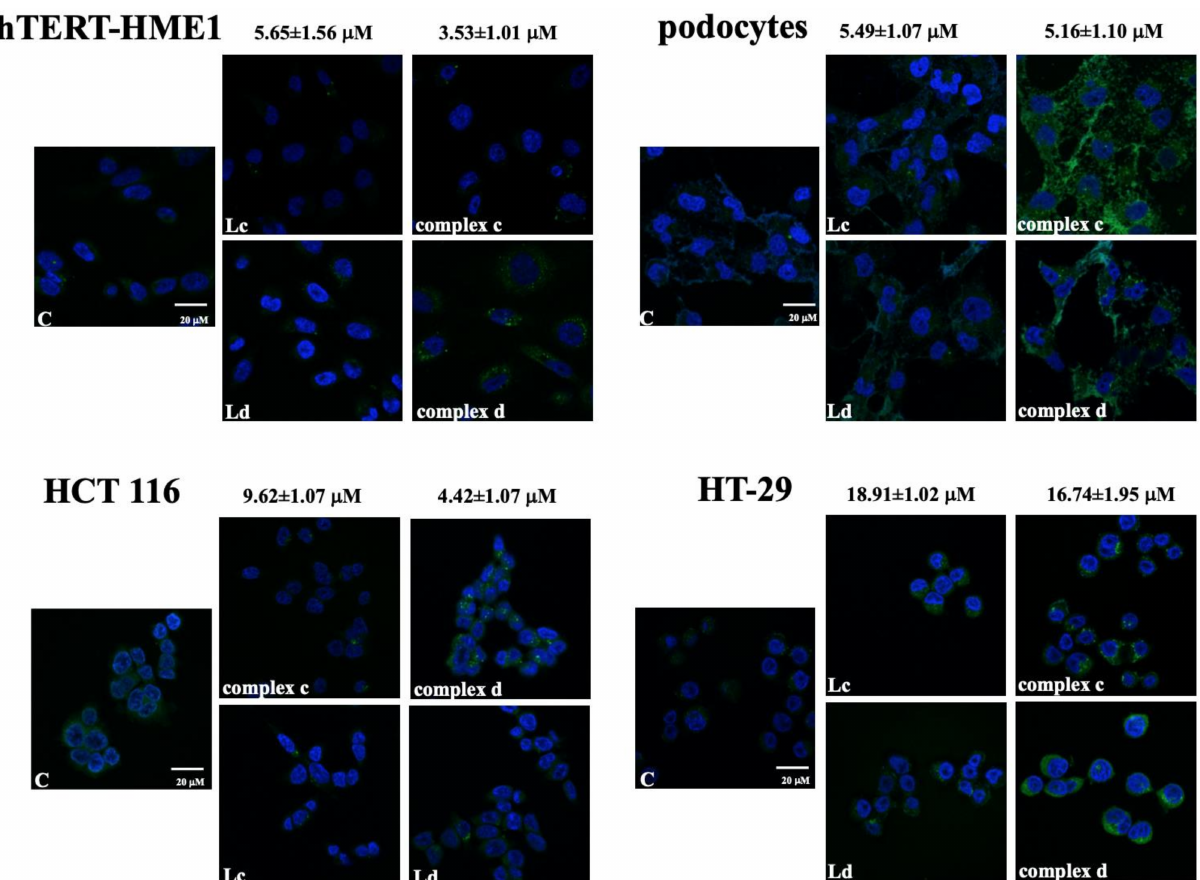
Figure 2. Intracellular localization of complexes c and d and their ligands (Lc and Ld). Cells were treated for 60 min with complexes used at the IC 50 calculated from the antiproliferative assay and with ligands used at the same concentrations of the respective complex. Concentrations utilized are indicated in the figure. Images are representative of one experiment of at least four